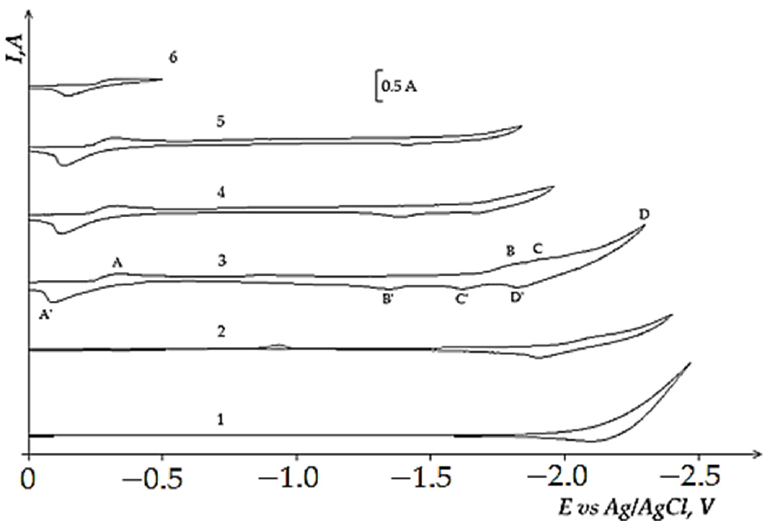
Figure 9. Cyclic voltammograms of electrochemical coreduction of Dy 3+ and Co 2+ ions on the tungsten electrode in the equimolar KCl-NaCl melt at 973 K, polarization rate of 0.2 V/s, and different reverse potentials: curves (1 and 2)—( − 2.4 V), curve 3 ( − 2.1 V), curve 4 ( − 1.96 V), curve 5 ( − 1.84 V), curve 6 ( − 0.4 V). Concentrations of DyCl 3 : curve 1—0 mol/cm 3 , curves (2–6)—3.0 × 10 − 4 mol/cm 3 . Concentrations of CoCl 2 : curve (1 and 2)—0 mol/cm 3 , curves (3–6)—5.0 × 10 − 5 mol/cm 3 . A square of the cathode is 0.4 cm 2 .